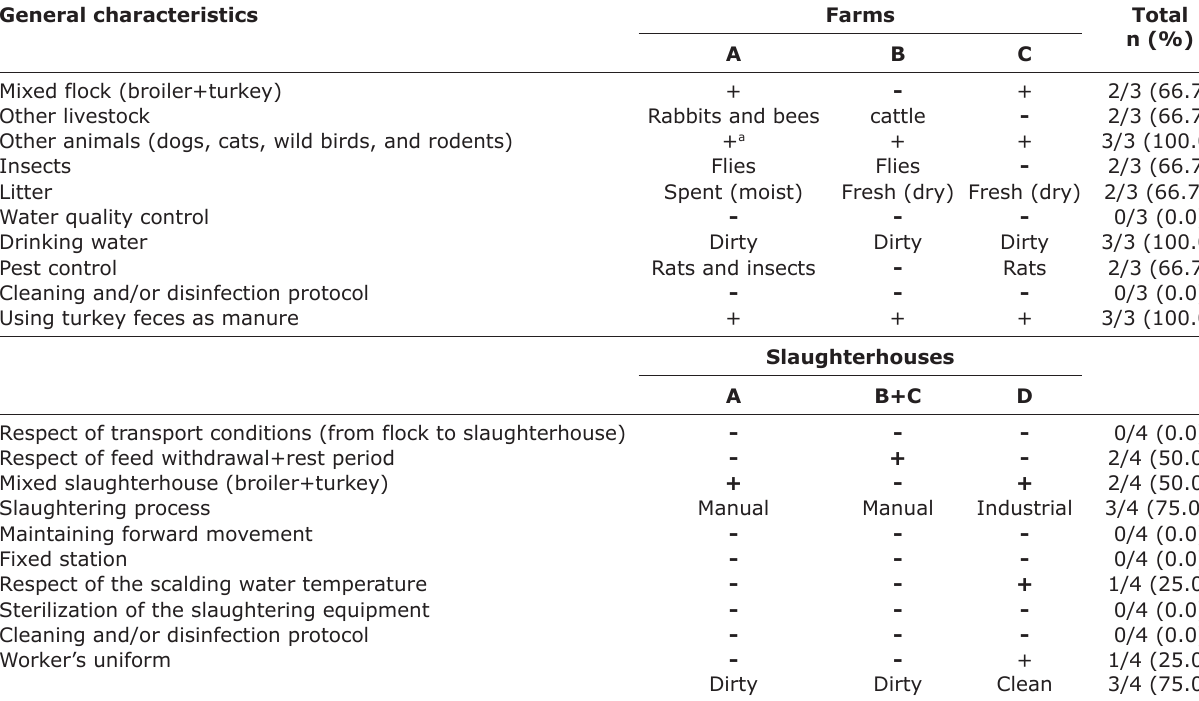
Table-1: Potential sources of Campylobacter transmission in farms and slaughterhouses. General characteristics